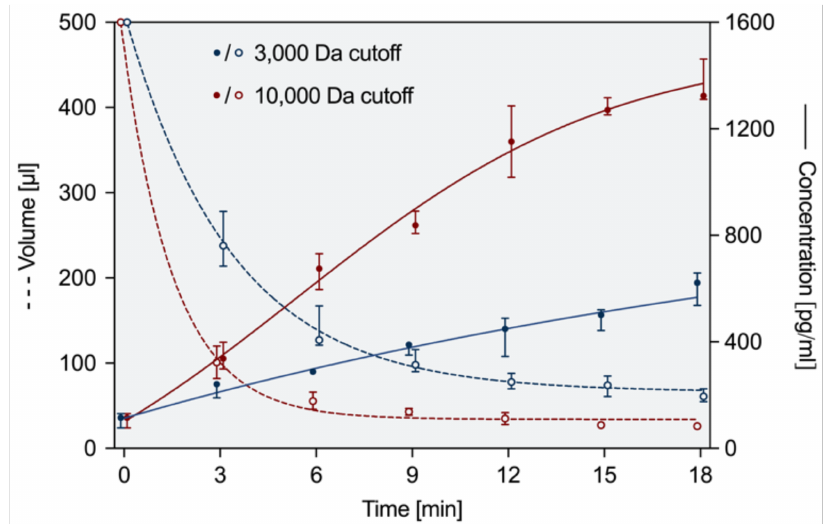
Figure 3. Volume of EDTA and concentration of TGF- β 1 after centrifugation in filters with a cut-off at 3000 or 10,000 Da. Both parameters were measured at 6 time points ( n = 6). Depicted are medians and 25–75%